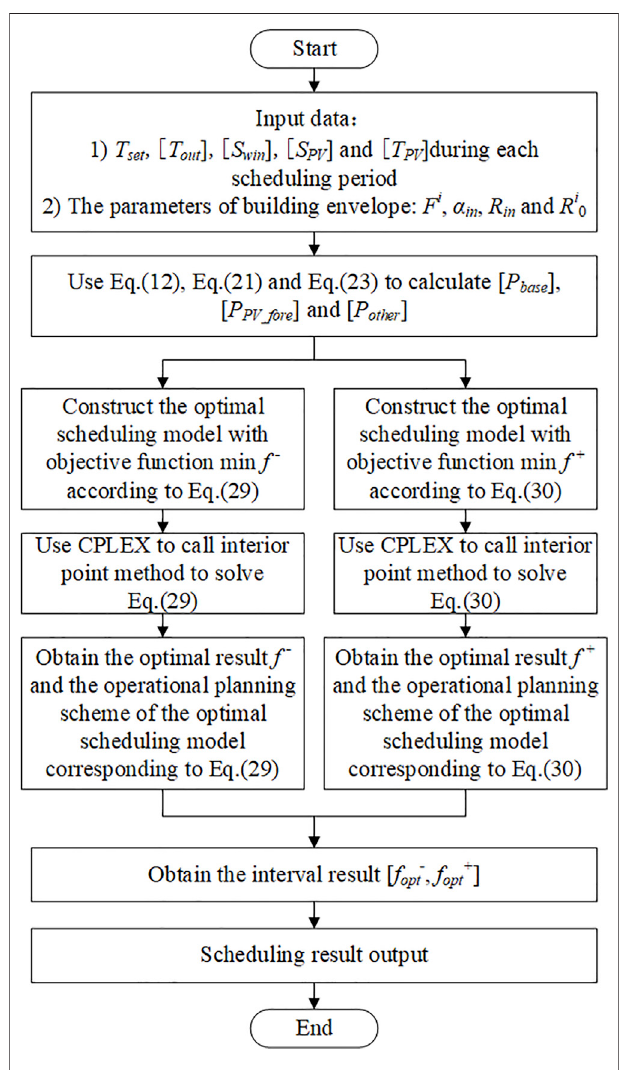
FIGURE 5 | Solution fl owchart of the day-ahead optimal interval scheduling